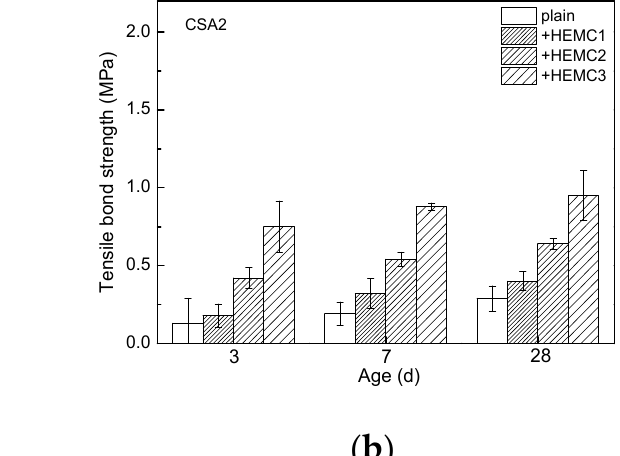
Figure 5. Tensile bond strength of CSA cement mortars with and without HEMCs at different curing ages: ( a ) CSA1, ( b ) CSA2.